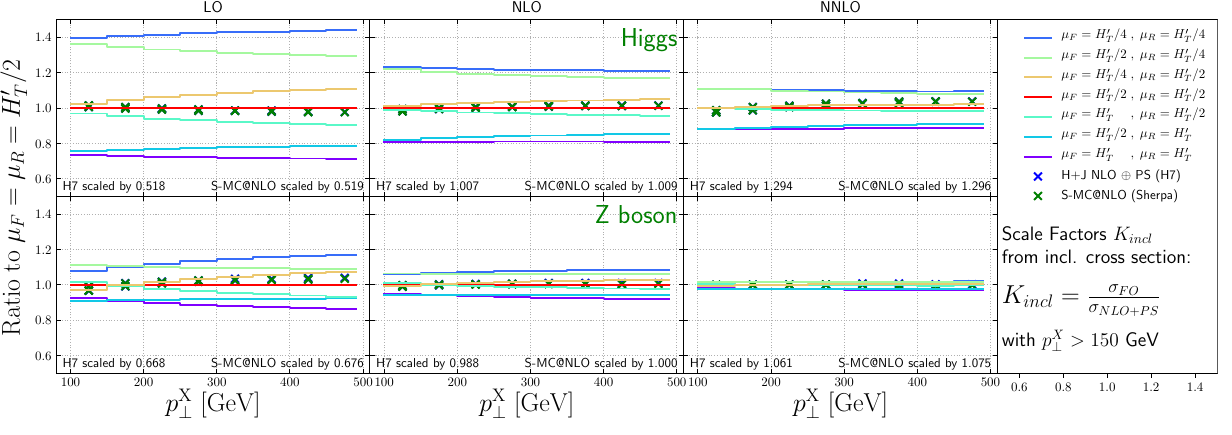
predictions are also shown. The generator predictions are scaled with the inclusive K incl factor with Higgs(Z) p ⊥ > 150 GeV, see Fig.